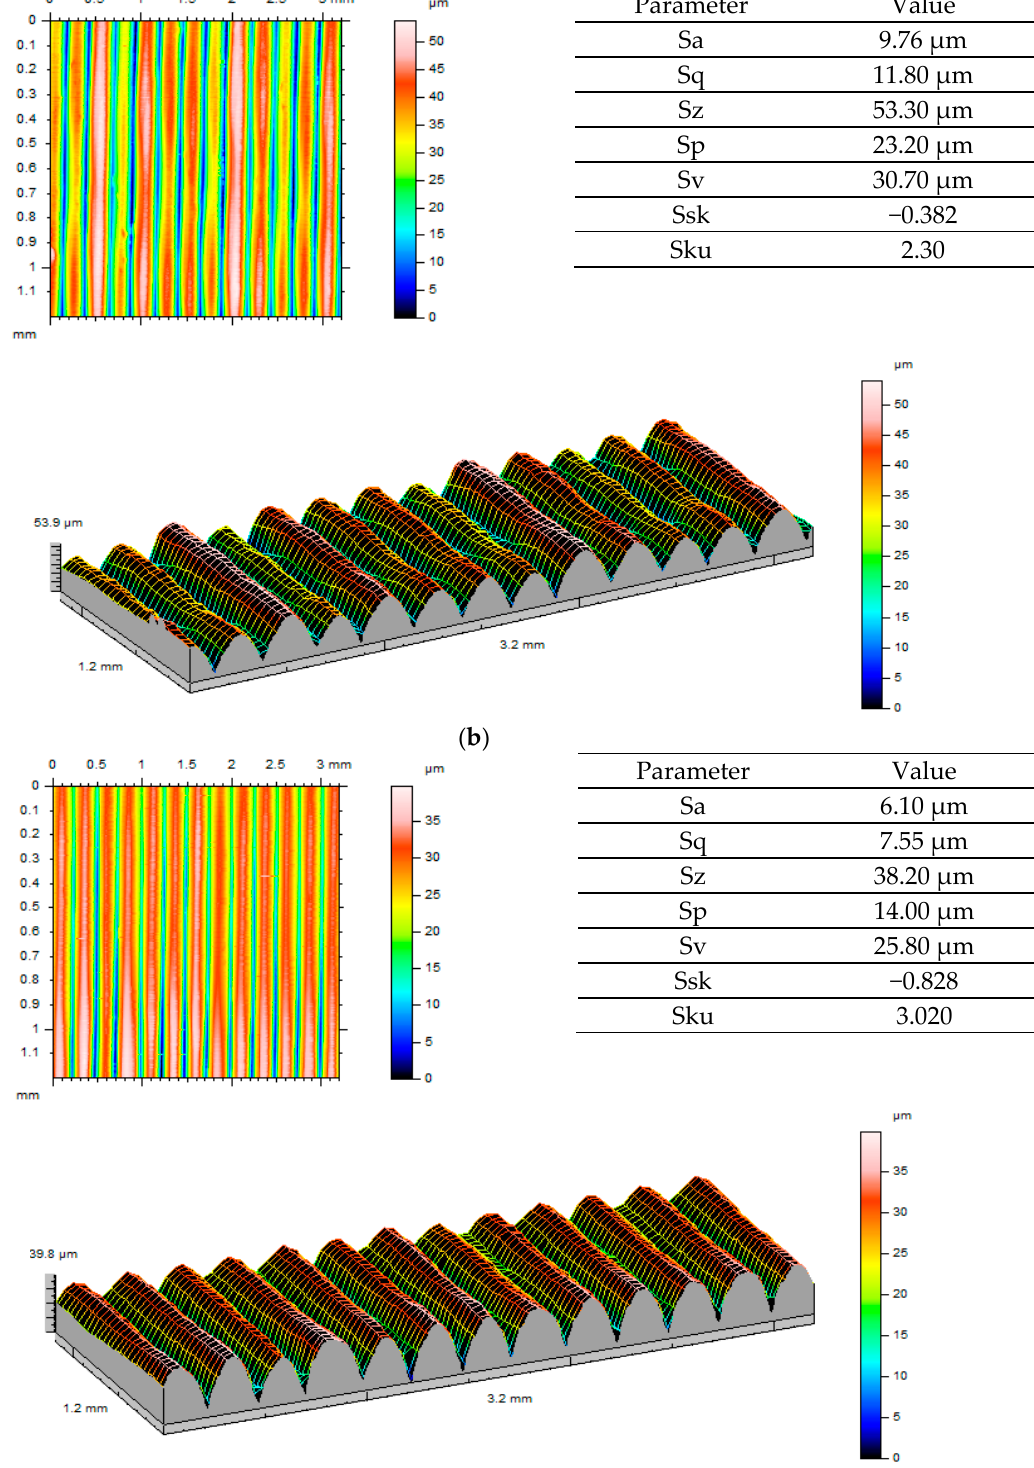
Figure 10. Roughness measurement results for the ABS material: ( a ) before testing; ( b ) after